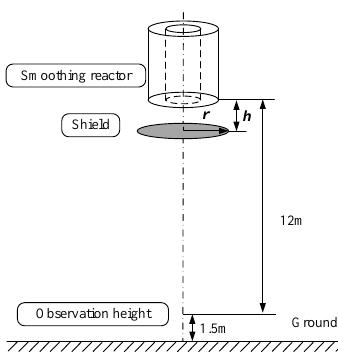
Figure 9. Shield installation diagram below the reactor. Figure 10 is a magnetic induction intensity distribution curve along the x axis direction 1.5 m